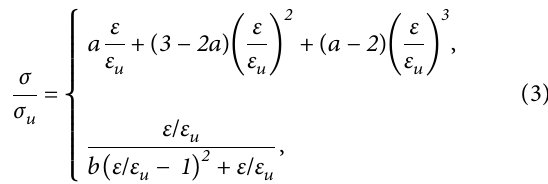
Figure 11: Model parameters (SE2